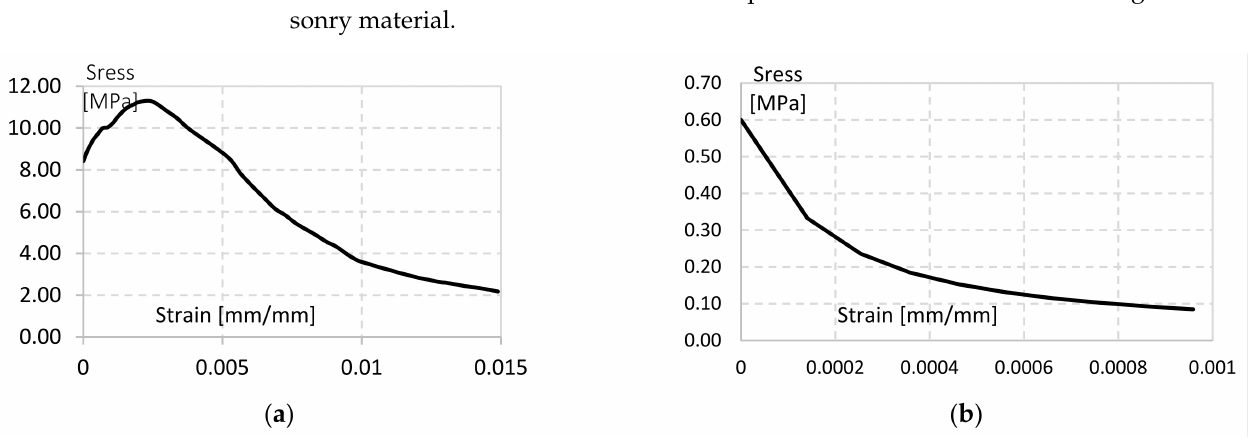
Figure 20. Inelastic stress-strain behavior for homogeneous FE model: ( a ) compression, ( b )